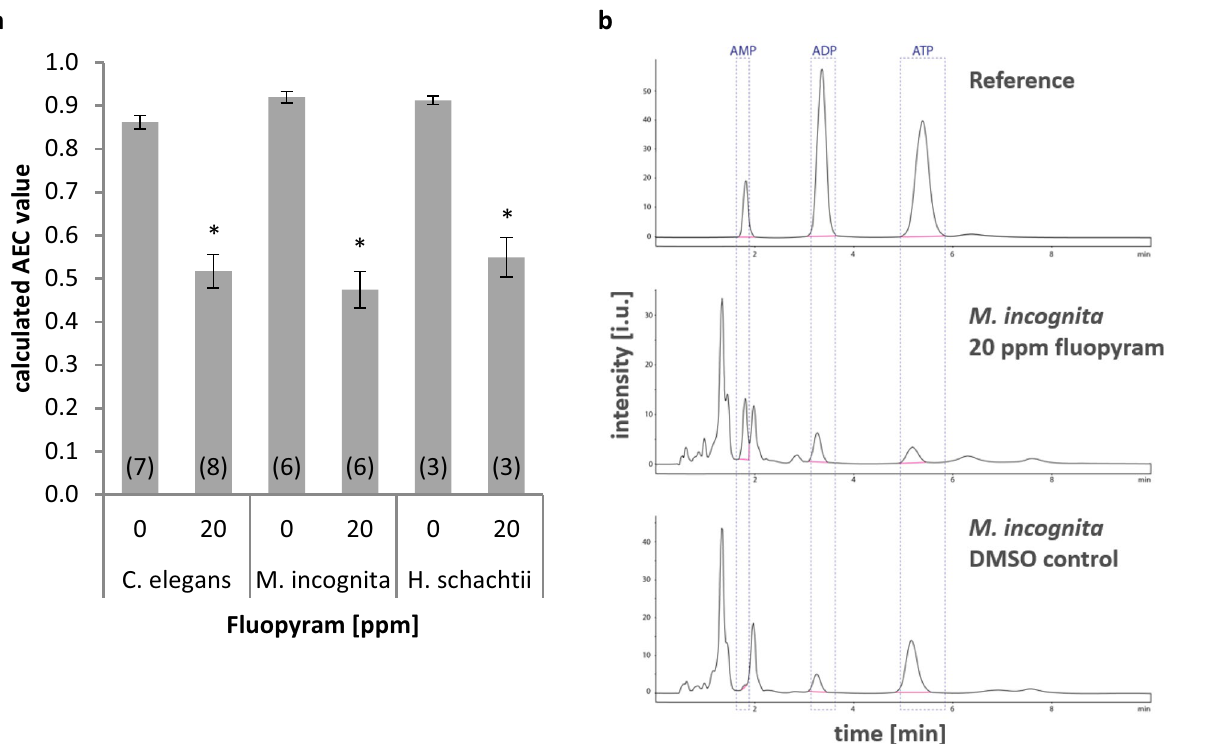
Figure 4. Impact of fluopyram on ATP generation of Caenorhabditis elegans , Meloidogyne incognita and Heterodera schachtii . Nematodes were incubated in DMSO or 20 ppm fluopyram for 48 h prior to measurement of adenylate energy charge (AEC). ( a ) AEC values were calculated from HPLC-traces. Values represented as mean ± SE of duplicates from three to eight independent biological replicates (indicated in brackets at the bottom of each bar). Asterisks indicate significant difference between DMSO control and treatment of each nematode species according to Holm-Sidak method ( p < 0.05). There is no significant difference between the treated variants. ( b ) Representative HPLC-traces. p <